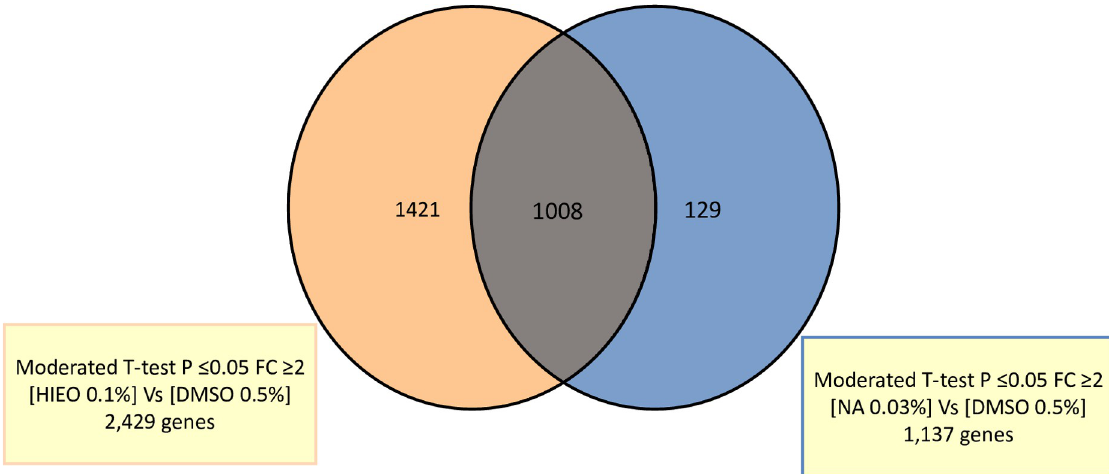
Fig 1. HIEO and NA share 1,008 regulated genes. Venn diagram showing the number of similarly and differentially regulated genes between HIEO and NA treatment. Numbers in no overlapping sections represent genes unique to HIEO or NA conditions, while numbers in overlapping areas represent genes shared by HIEO or NA